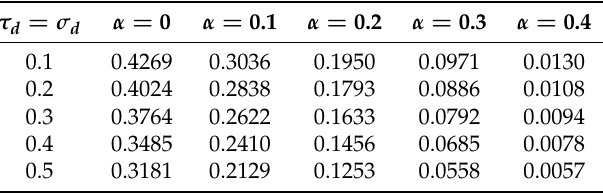
Table 3. Maximum allowable upper bounds b of Example 1.